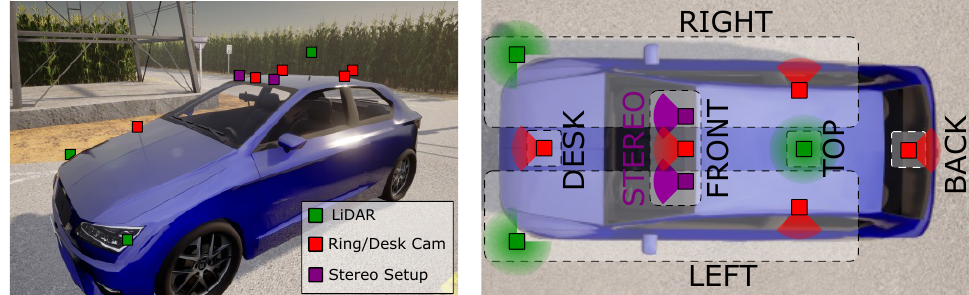
Figure 2. Figure (derived from the one in [39]) showcasing the multi-sensor setup used in the data